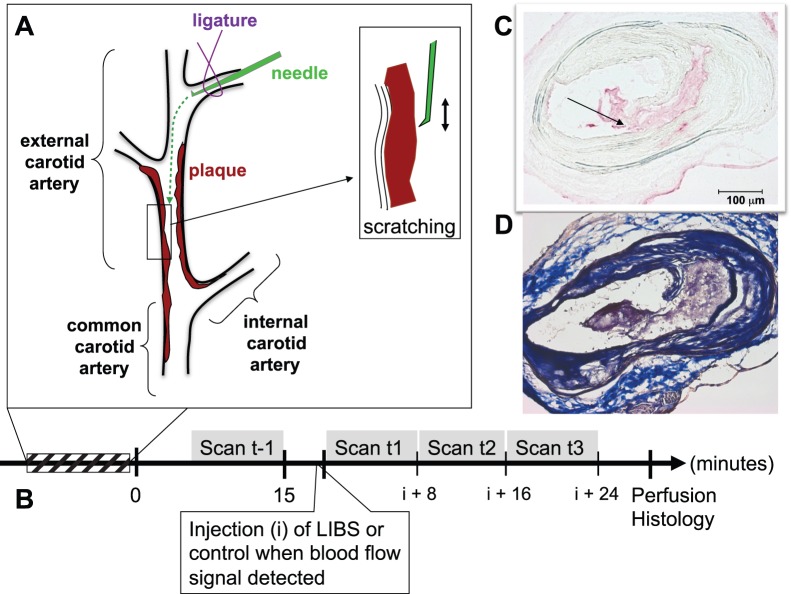
The experimental design.(A) Cartoon depicting the model used for inducing atherothrombosis. A tiny curved needle introduced through a branch of the external carotid was advanced up to the plaque surface under persistent blood flow. After positioning the tip of the needle in front of the plaque, it was applied to the plaque and moved forth and back twice in order to scratch the fibrous cap. (B) The experimental timeline. “I” stands for injection. (C) Transversal histological section of the carotid artery after the scratch injury. Immunohistochemistry depicts platelets and therefore thrombus in red. The scratch with superimposed thrombosis is clearly visible and induced here a small dissection (arrow). A corresponding section of the site of the plaque rupture stained with Masson-Trichrome is depicted in (D).